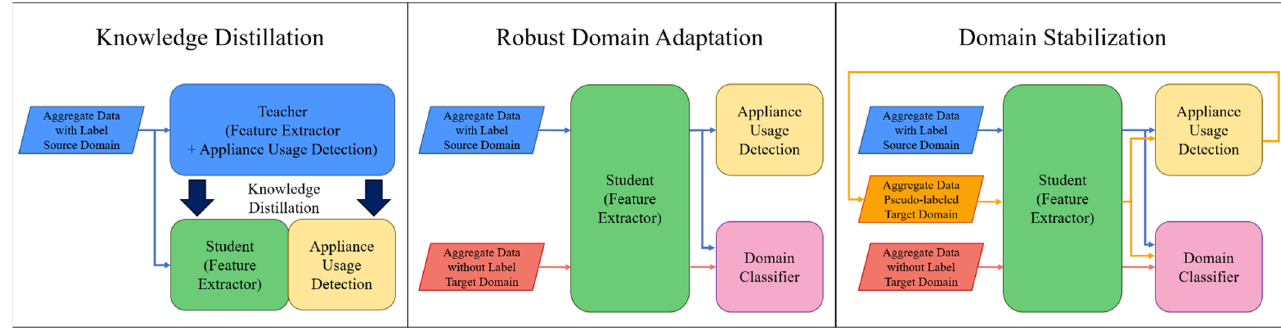
Figure 2. Step ‐ by ‐ step flowchart of the proposed